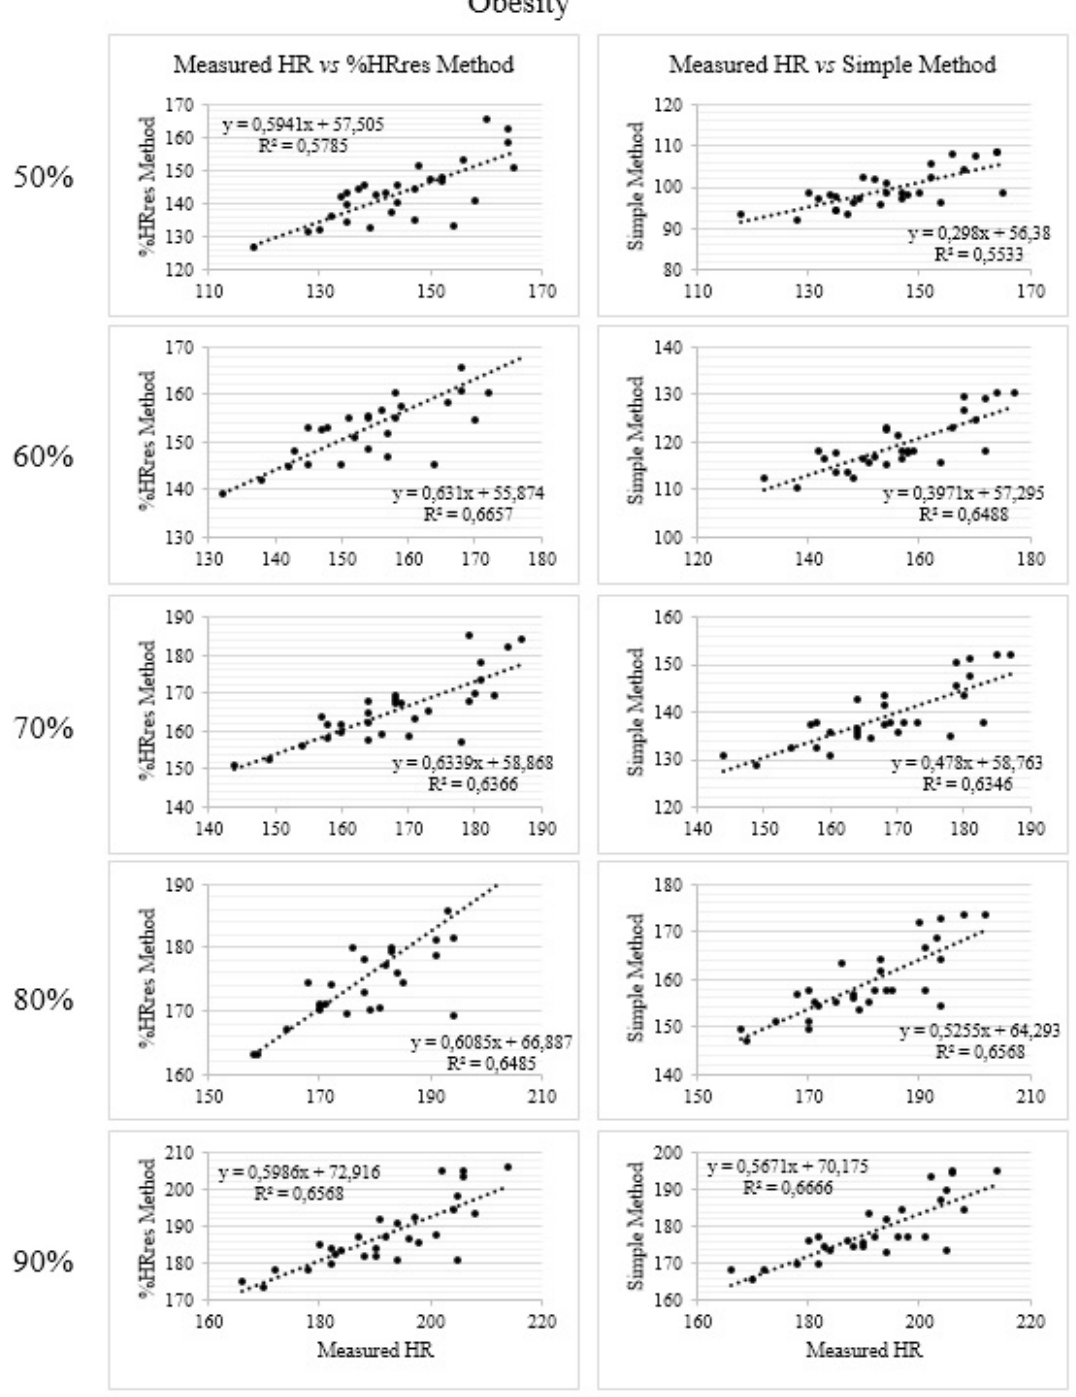
Figure 3. Correlation between measured HR vs. predicted %HRres method and measured HR vs predicted simple method (HRmax) in obesity in both genders